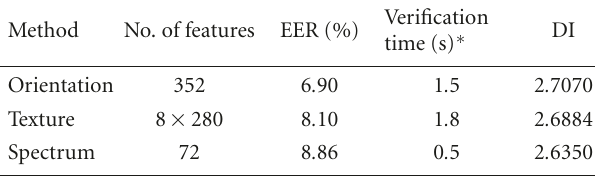
Table 2: Performance indexes for nonminutiae-based verification methods.